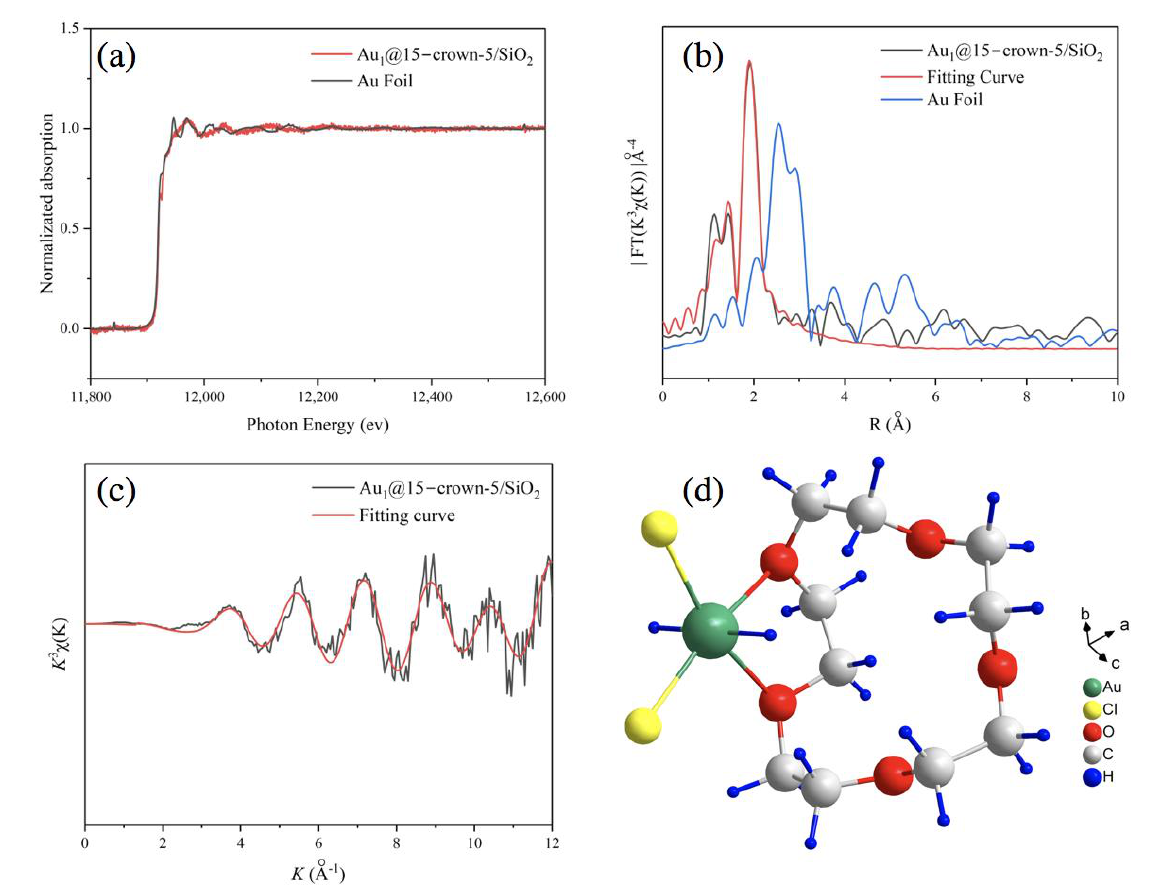
Figure 4. X-ray absorption spectroscopy analysis (XAS) of Au 1 @15-crown-5: ( a ) E-Space of Au 1 @15-crown-5/SiO 2 and Au foils; ( b ) R-space of Au 1 @15-crown-5/SiO 2 , Au foil and fitting curve; ( c ) K-Space of Au 1 @15-crown-5/SiO 2 and fitting curve; and ( d ) structure mode of Au@15-crown-5.